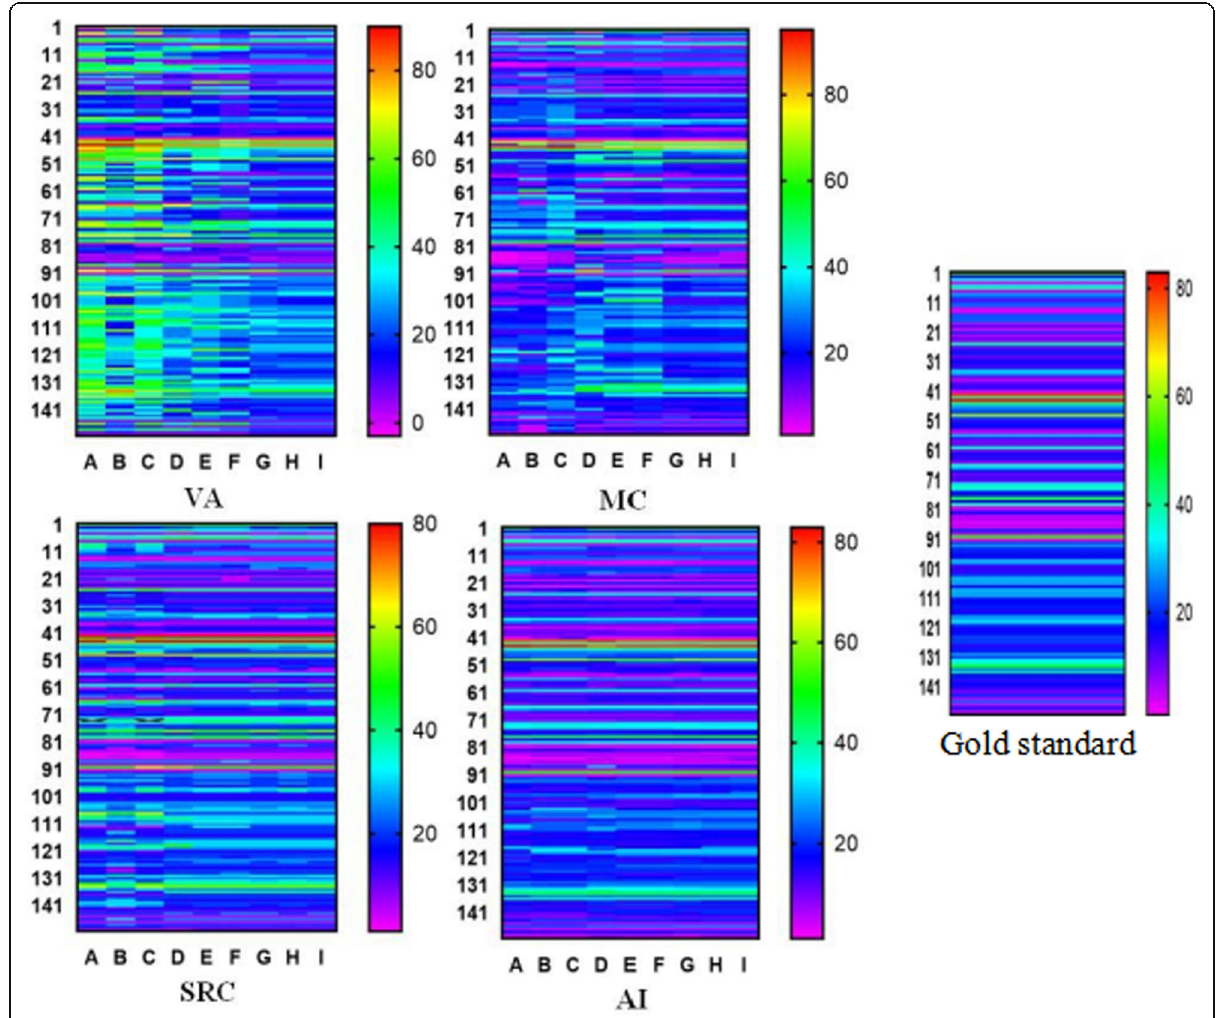
Fig. 6 Nine pathologists interpreted breast cancer Ki-67LI heat map through VA, MC, SRC,